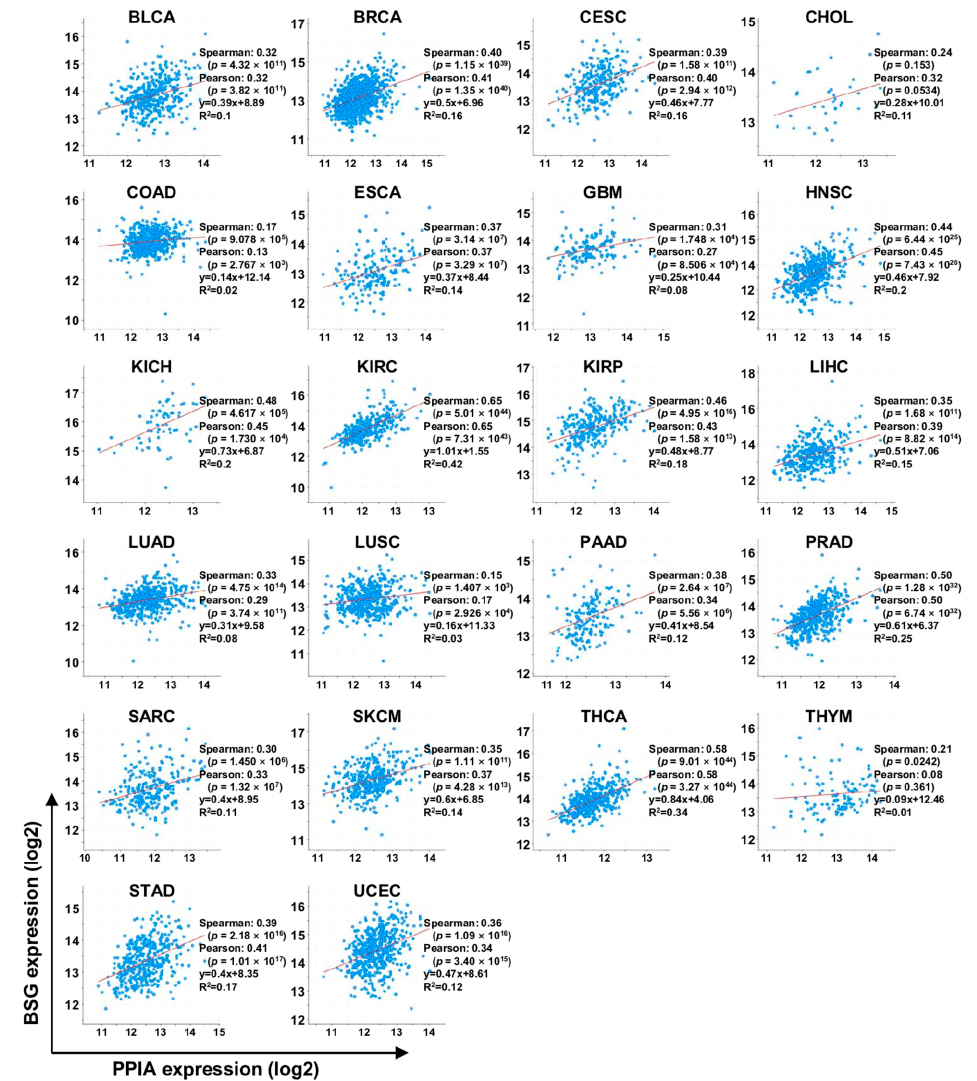
Figure 8. Correlation between transcription levels of PPIA and BSG . The data were obtained through cBioPortal analysis using the TCGA database. The full name of each carcinoma is described in the legend in Figure 5.